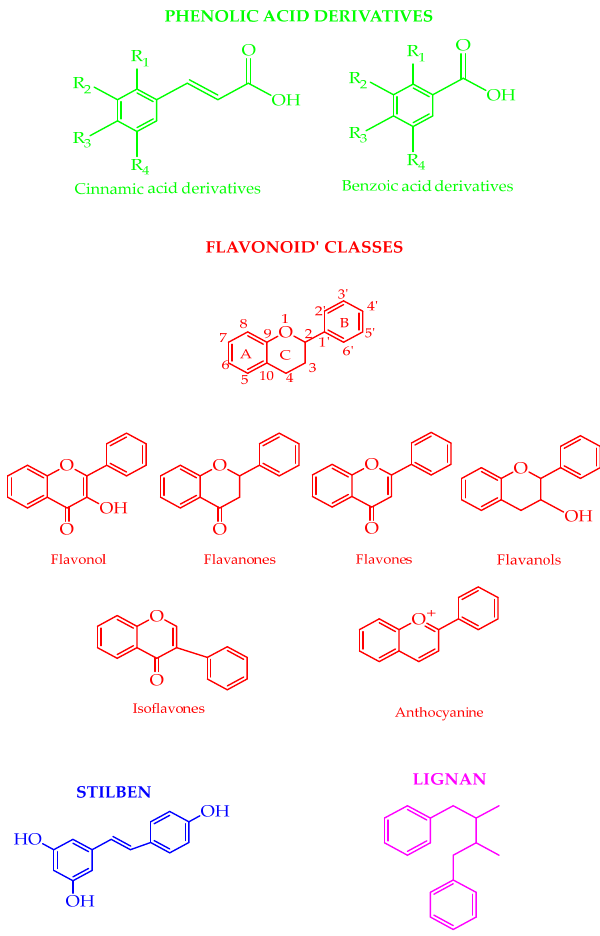
Figure 1. Chemical structures of the different polyphenol classes. The colors indicate the sub-class. The numbers indicate the positions in the nomenclature.